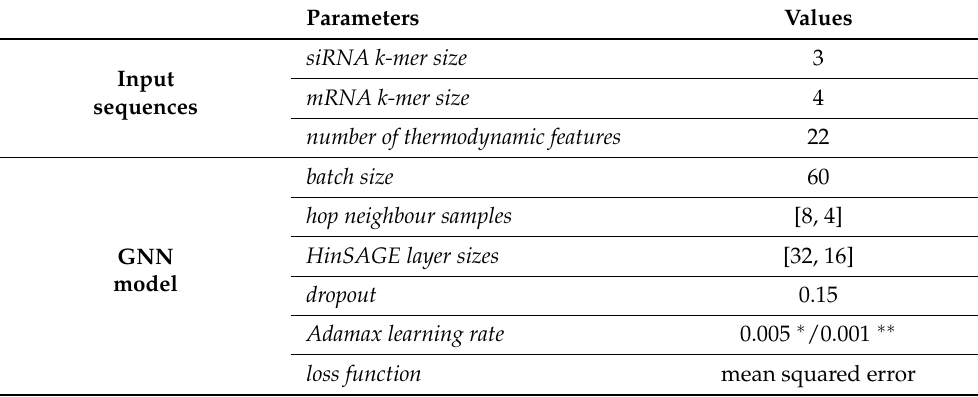
Table 1. Parameters and hyperparameters of the input sequences and GNN model, respectively. The same values were used for all datasets, except for the Adamax learning rate, where ∗ refers to dataset_2 and ∗∗ refers to the other two